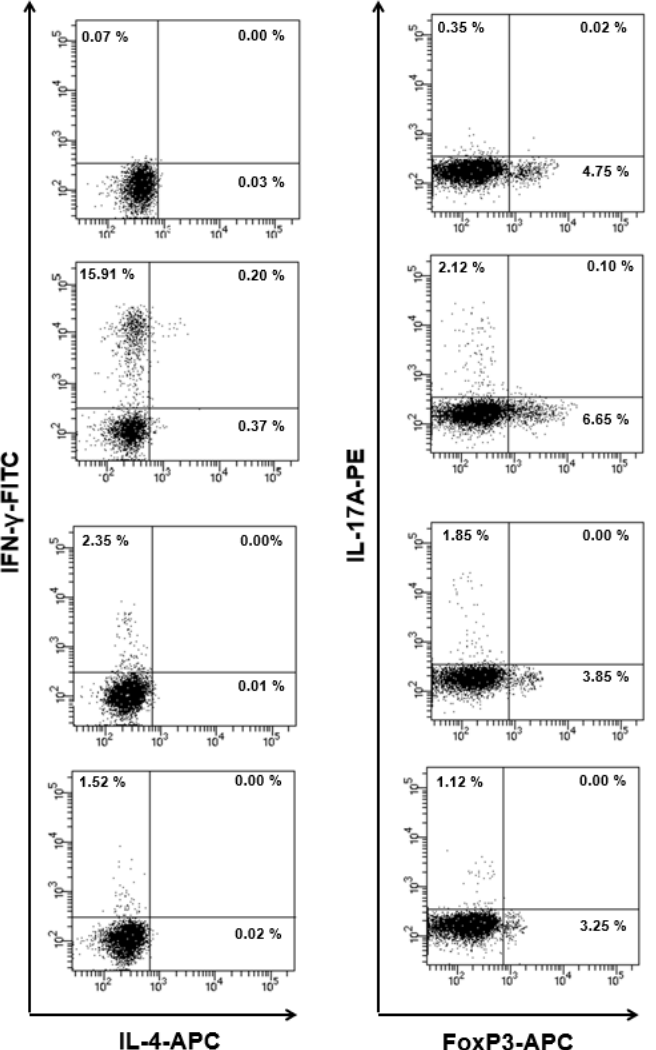
Figure 2. Flow cytometry analysis of intracellular proteins characteristic for specific Th subsets after exposition of PBMC to TMCPM. ( A ) Gating strategy for CD4 + T cell identification. Lymphocytes were defined according to FSC vs. SSC parameters from PBMC and then Th cells were gated according to CD4 expression. ( B ) Dot plots (IFN- γ -FITC vs. IL-4-APC; IL-17A-PE vs. FoxP3-APC) show CD4 + T cells positive for IFN- γ , IL-4, IL-17A and FoxP3 in unstimulated control, cells stimulated with PMA (50 ng / mL) + ionomycin (100 ng / mL) (positive control) or stimulated with NIST (100 µ g / mL) or LAP (100 µ g / mL). Shown are data from one representative experiment out of thirteen performed. The expression of intracellular proteins IFN- γ , IL-4, IL-17A and FoxP3 was analyzed by flow cytometry after the cells were staining with the cocktail of fluorescently conjugated monoclonal antibodies, specific for IFN- γ (Th1), IL-4 (Th2), IL-17A (Th17) and FoxP3 (Treg).